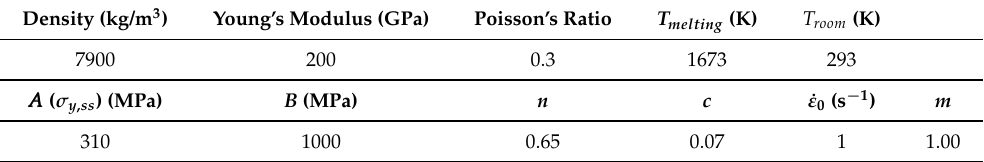
Figure 2. Visualization of the NACA 63-8XX blade-killer whale finite element model [29]. Table 2. Material properties of Johnson–Cook parameters for the stainless steel material of Grade 304.